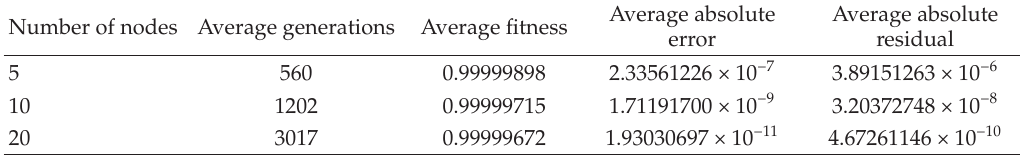
Table 15: The influence of the number of nodes on the convergence speed and the corresponding error for Problem 4.